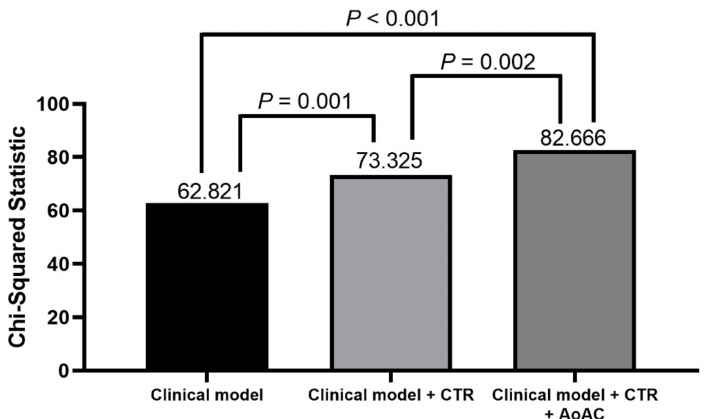
Figure 5. The assessment of predictive model of cardiovascular mortality. The clinical model included age, sex, smoking history, diabetes, coronary artery disease, cerebrovascular disease, fasting glucose, total cholesterol and antiplatelet agent use (variables in Table 3 of p < 0.05 in univariable